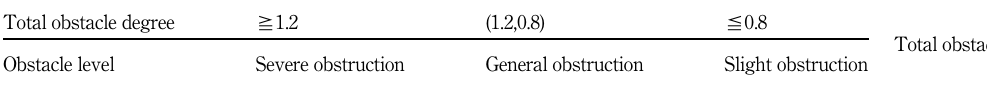
Table 2. Total obstacles grade